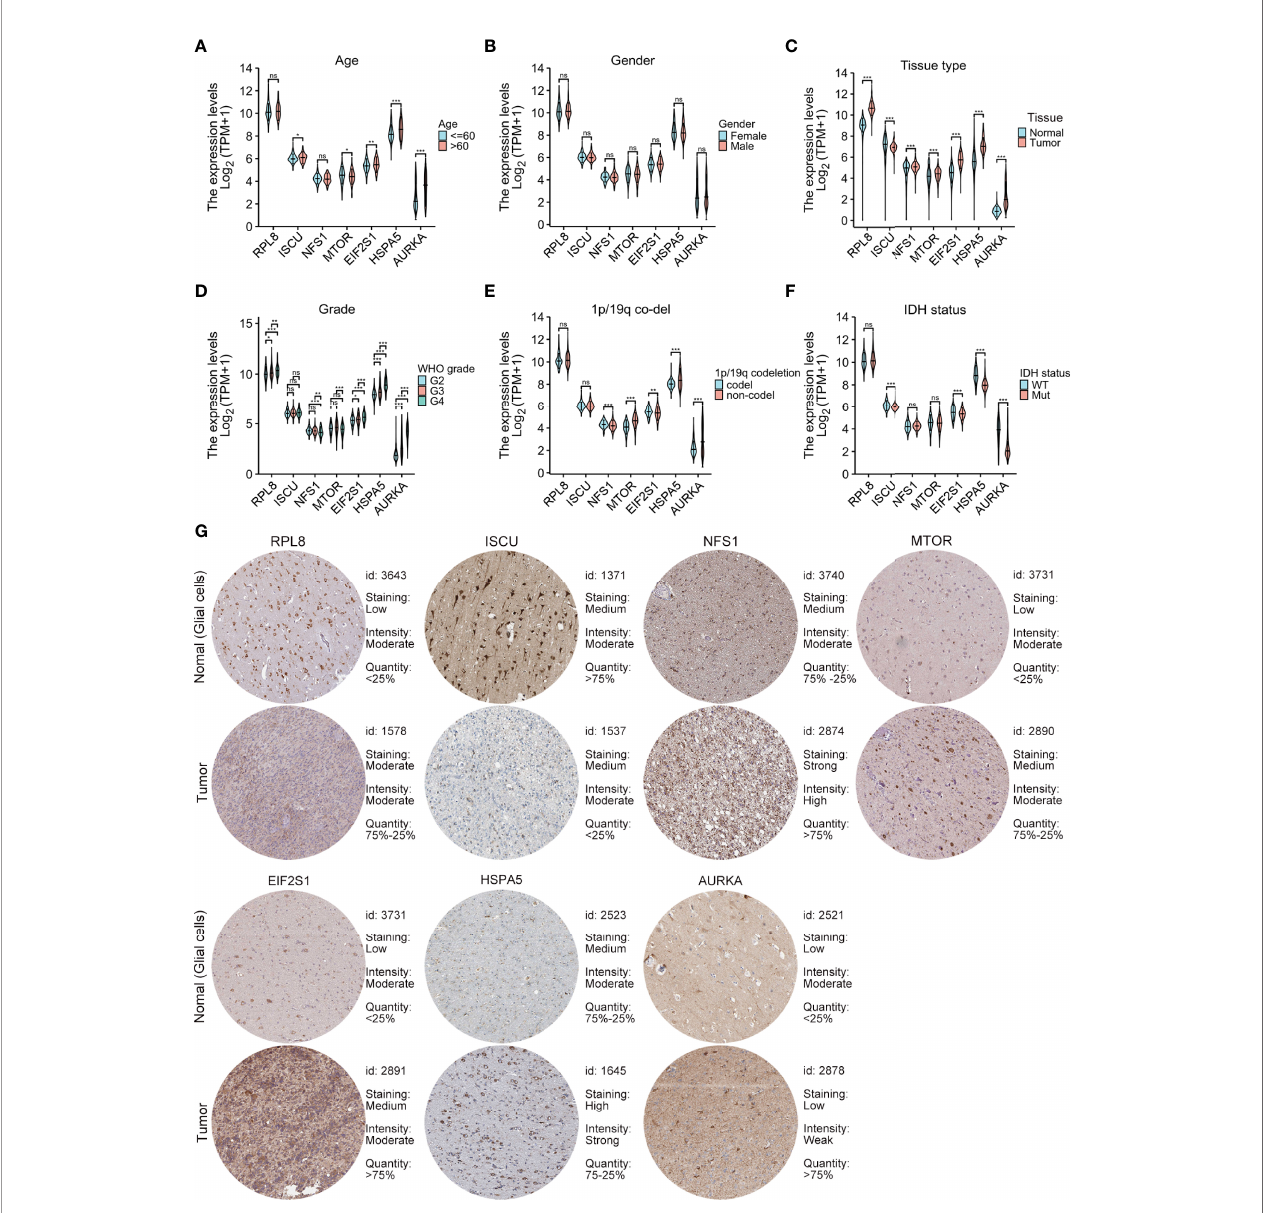
FIGURE 4 | Relationships between the levels of the seven cancer-essential FRGs and clinical features. Age (A) , sex (B) , normal versus tumor tissue (C) , WHO grade (D) , 1p/19q co-deletion status (E) , and IDH status (F) . Immunohistochemistry showing the protein expression of risk model genes in normal and tumor specimens of The Human Protein Atlas (G) . ns, p ≥ 0.05, *p < 0.05, **p < 0.01, ***p <